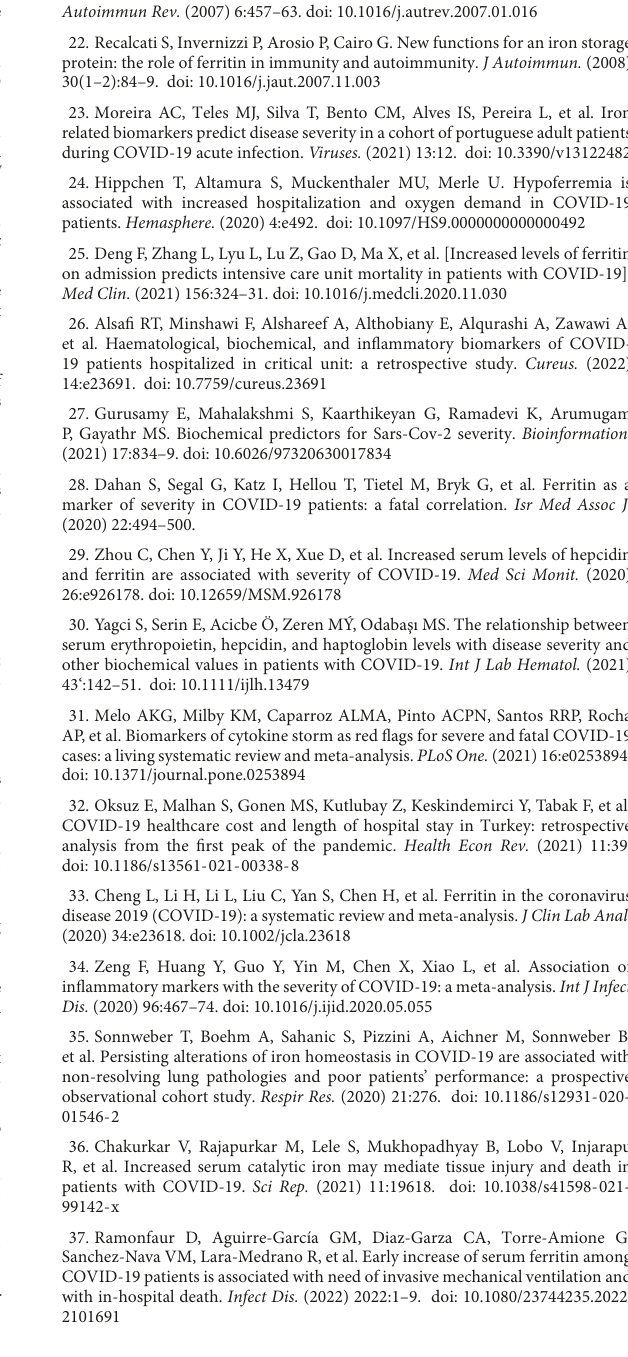
SUPPLEMENTARYFIGURE1 Time to peak serum ferritin in patients with and without psychiatric comorbidity. About 13 and 14% of patients with and without psychiatric comorbidity respectively reach peak serum ferritin in days 4 and 3 post SARS-CoV-2 positive test.